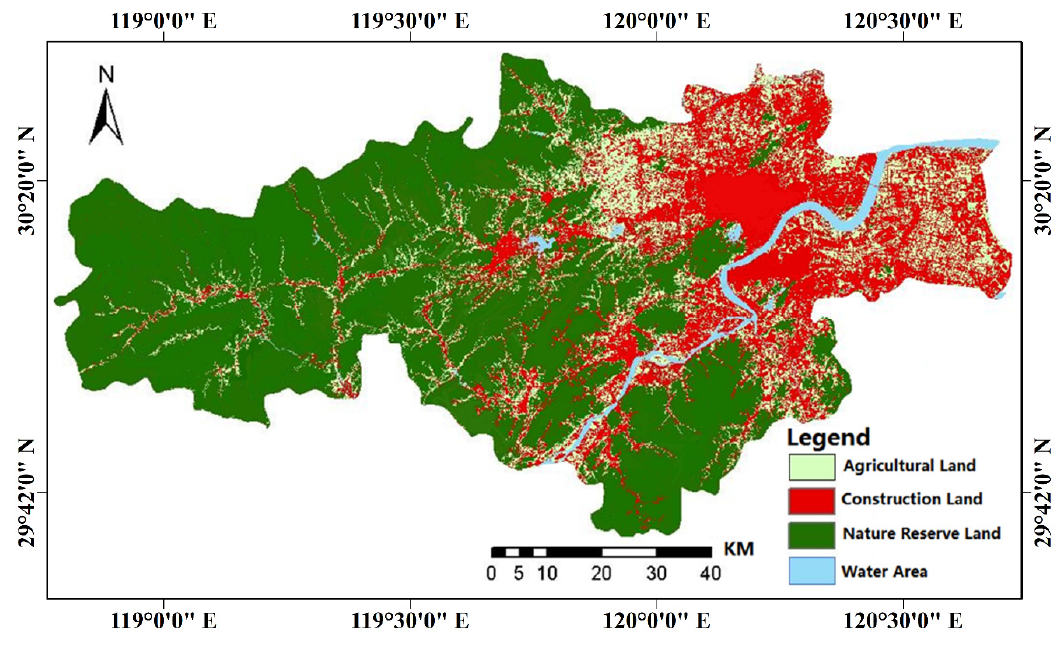
Figure 14. The 2020 land-use prediction map.